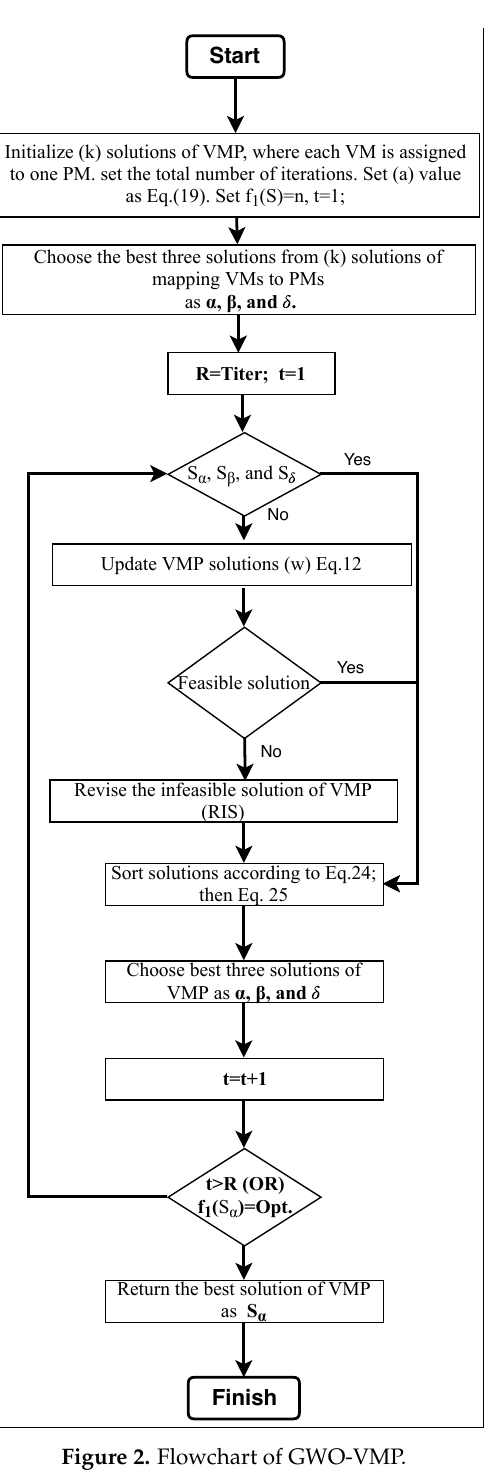
Figure 2. Flowchart of